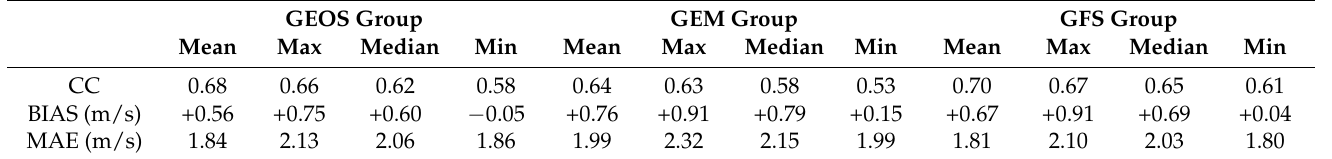
Table 2. Statistical verification of all stations for the GFS, GEOS, and GEM groups (45 days). GEOS Group GEM Group GFS